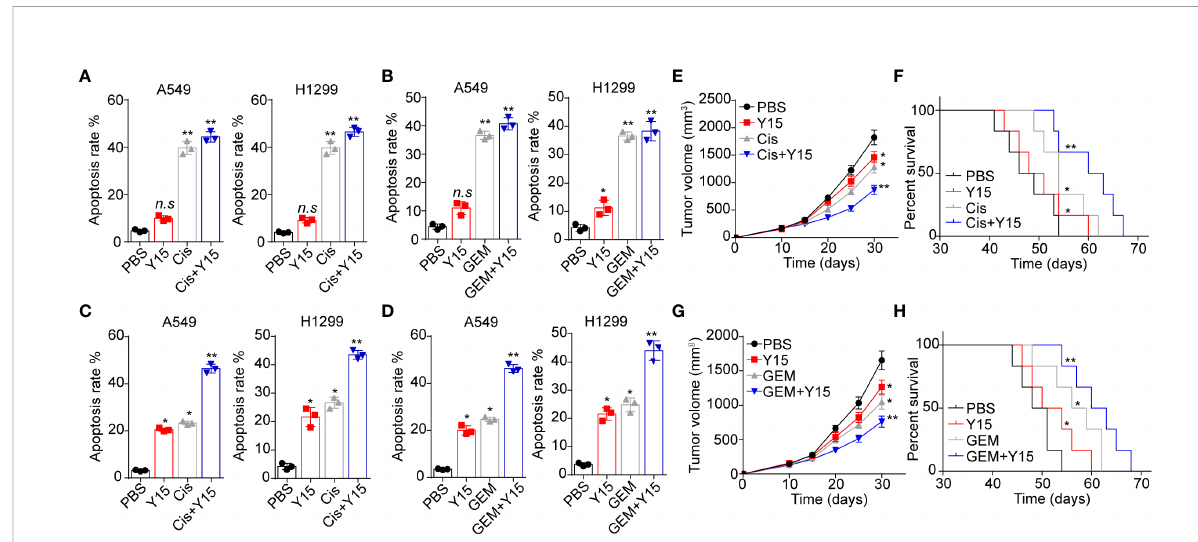
FIGURE 5 Blockade of integrin/FAK/YAP/TAZ signals suppressed the NSCLC development. (A) , A549 and NCI-H1299 cells were cultured on fl ask and treated with PBS, Y15 (1 m M), Cis (2 m g/ml) and Y15 (1 m M) combing Cis (2 m g/ml). Then the cell apoptosis was determined. (B) , A549 and NCI- H1299 cells were cultured on fl ask and treated with PBS, Y15 (1 m M), GEM (1 m g/ml) and Y15 (1 m M) combing GEM (1 m g/ml). Then the cell apoptosis was examined. (C) , A549 and NCI-H1299 cells were cultured on 2D collagen gels containing laminin and treated with PBS, Y15 (1 m M), Cis (2 m g/ml) and Y15 (1 m M) combing Cis (2 m g/ml). Then the cell apoptosis was assessed. (D) , A549 and NCI-H1299 cells were cultured on 2D collagen gels containing laminin and treated with PBS, Y15 (1 m M), GEM (1 m g/ml) and Y15 (1 m M) combing GEM (1 m g/ml). Then the